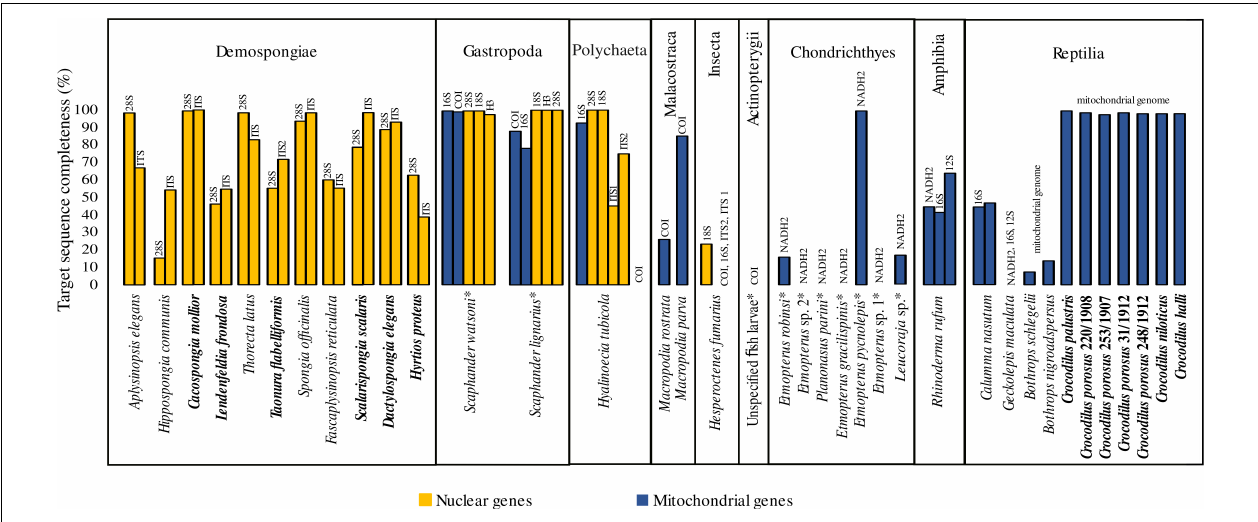
Frontiers in Ecology and Evolution |